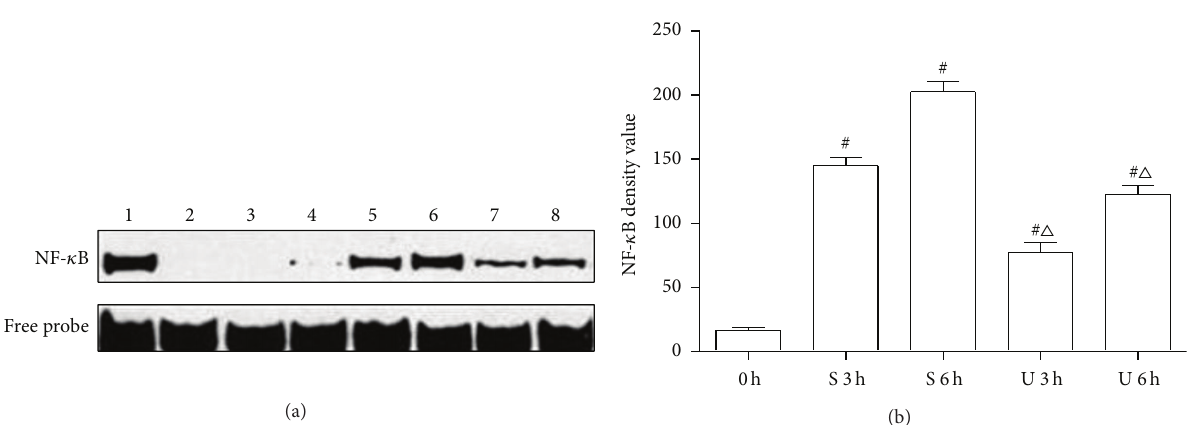
Figure 3: Effects of UTI on inhibition of NF- 𝜅 B activity. (a) Shifted band of NF- 𝜅 B DNA complexes. Lane 1: positive control, lane 2: negative control, lane 3: cold competition assay, lane 4: C group, lane 5: S group at 3 h, lane 6: S group at 6 h, lane 7: U group at 3 h, and lane 8: U group at 6 h. (b) Amount of NF- 𝜅 B DNA complexes. 0h = C group; S 3h = S group at 3 h; S 6h = S group at 6h; U 3 h = U group at 3h; U 6 h = U group at 6h. # 𝑃 < 0.05 versus C group and △ 𝑃 < 0.05 versus S group at matched time.